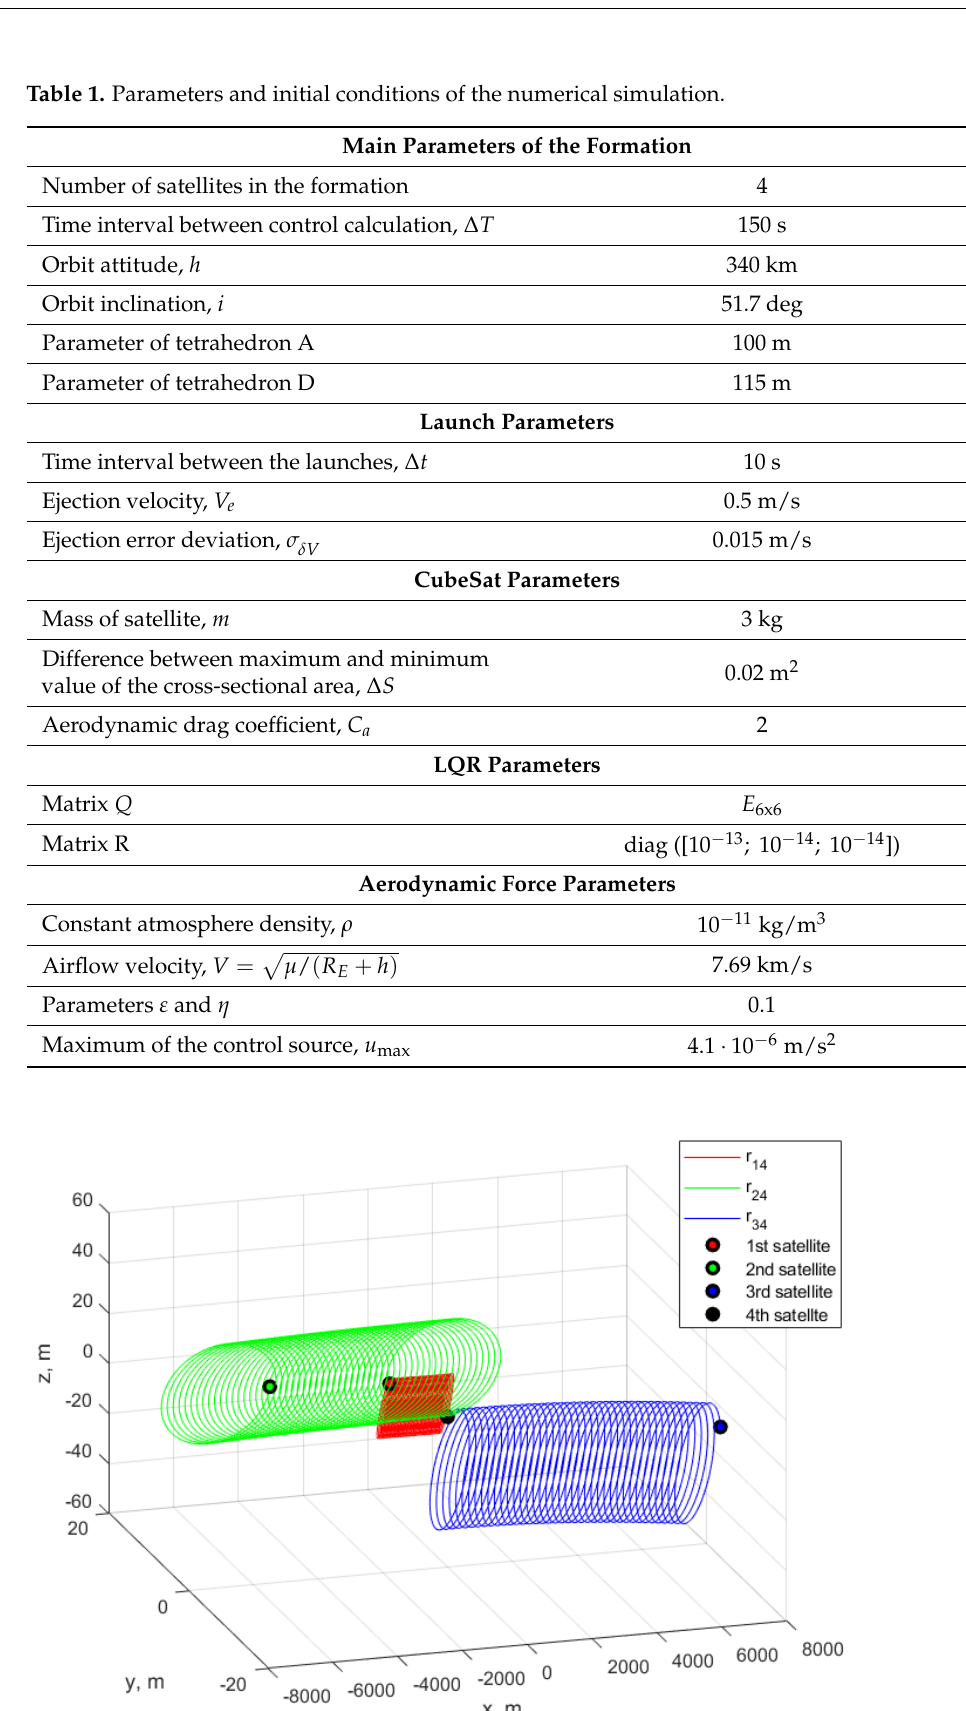
Figure 4. Relative trajectories under the proposed control algorithm.